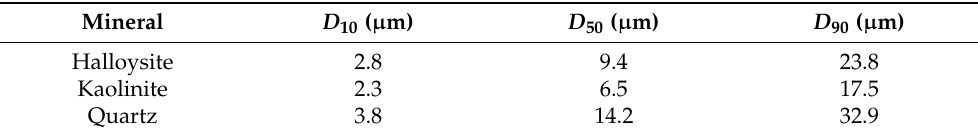
Table 2. D 10 , D 50, and D 90 values of <38 µ m sized